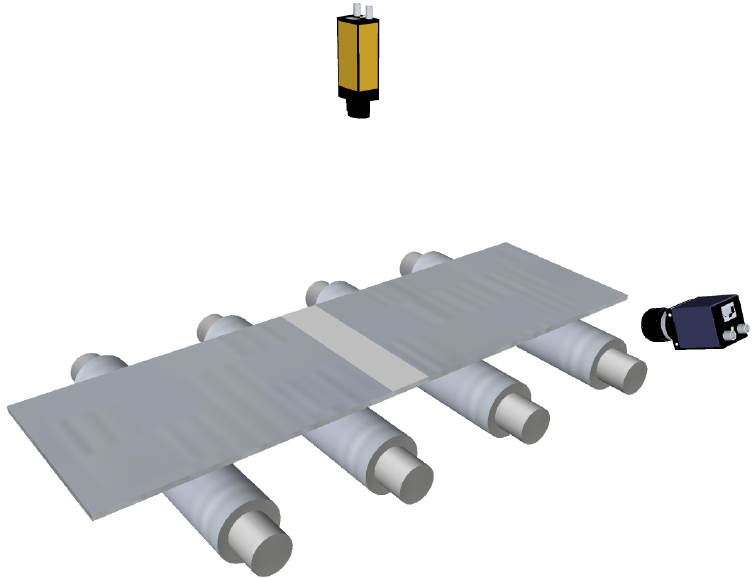
Figure 12. Flatness sensor based on diffuse light